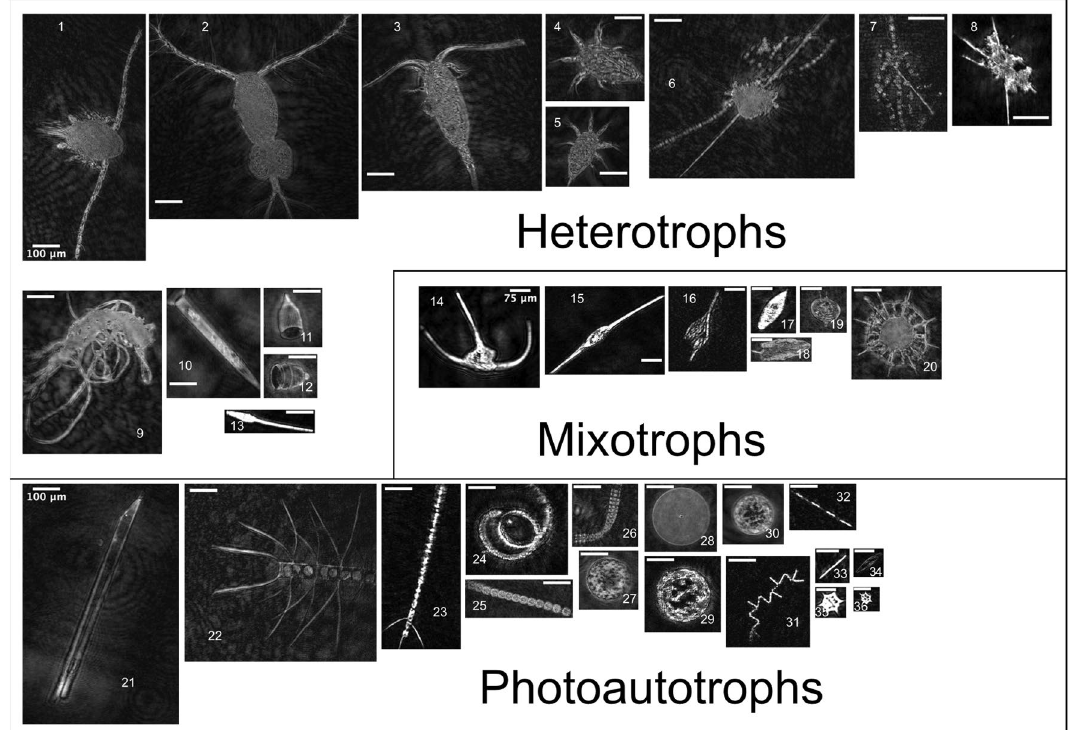
Figure 4. A collection of eukaryotic taxa observed on the Newfoundland Shelf. Groups are broadly divided into trophic level with respective scale bars, labelled at image 1, 14, and 21. Heterotrophs included adult copepods (1–3), larval nauplii (4–5), the saprophytic phylum Labyrinthulomycetes (6–8), the Amoebozoa Platyamoeba (9), tintinnids (10–12), and appendicularians (13). Mixotrophic dinoflagellates (14–19) included several genera of Tripos (14–16), with Tripos fusus (15) and Tripos lineatum (16), Gyrodinium (17), Prorocentrum (18), and Protoperidinium (19). The heterotrophic radiolarian Acantharia (20) commonly bears photosynthetic symbionts, creating mixotrophic nutrition 41 . The photosynthetic autotrophs included diatoms (21–35), and the silicoflagellate genera Dictyocha (35–36). The diatom genera included Proboscia (21), Chaetoceros (22–24), plus taxonomically unresolved chain-forming (25–26) and centric groups (27–30), Thalassionema (31), Pseudo-nitzschia (32), rod-shaped groups (33), and Nitzschia (34). To highlight additional data-driven benefits of holography, partially focused images (e.g., 21 and 23) produced from our methods can be refocused from raw holograms using, for example, an oblique reconstruction to recover obscured features outside the plane perpendicular to the optical axis 42